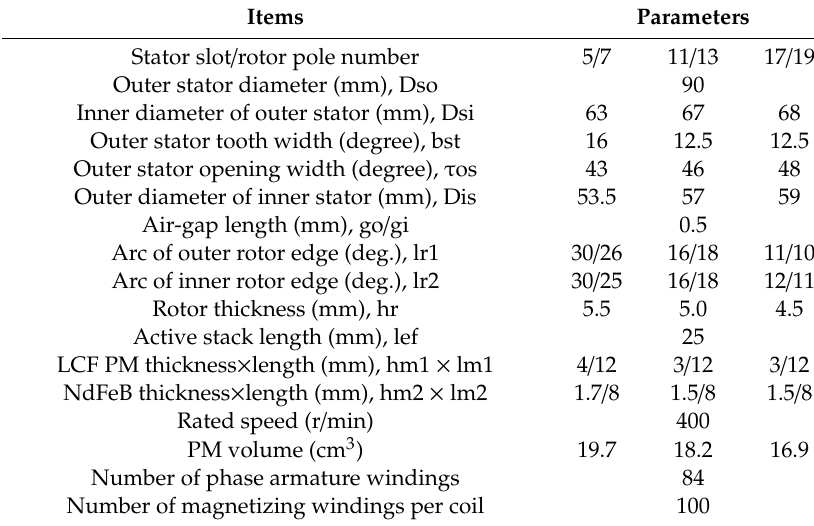
Table 2. Design Specifications of the 6-Stator-Slot PS-SF-HMMMs.